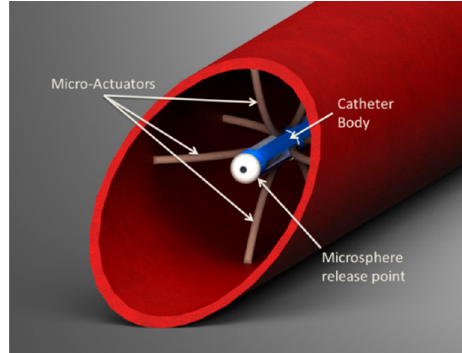
Figure 2. Shape memory alloy (SMA) flexural actuators could enable precise positioning of microcatheter tips within the common hepatic artery.